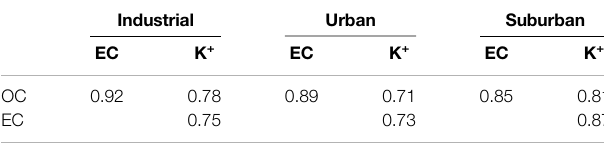
TABLE 2 | Correlations between OC, EC, and water-soluble ions (K + ) in study locations. Industrial Urban